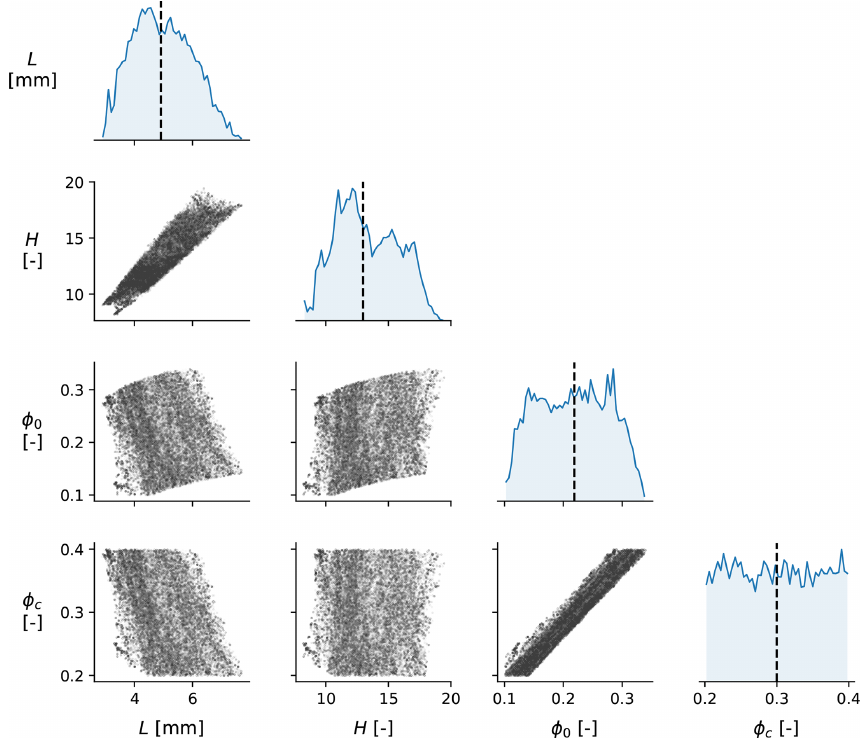
Figure 6. Corner plot of the posterior distributions of the inverted parameters L , H , φ 0 , and φ c (marginalised over the nuisance parameter ν 2 ) for the field injection experiment. The main diagonal panels show the posterior probability density distribution of each parameter, whereas the off-diagonal panels show the co-variance of posterior